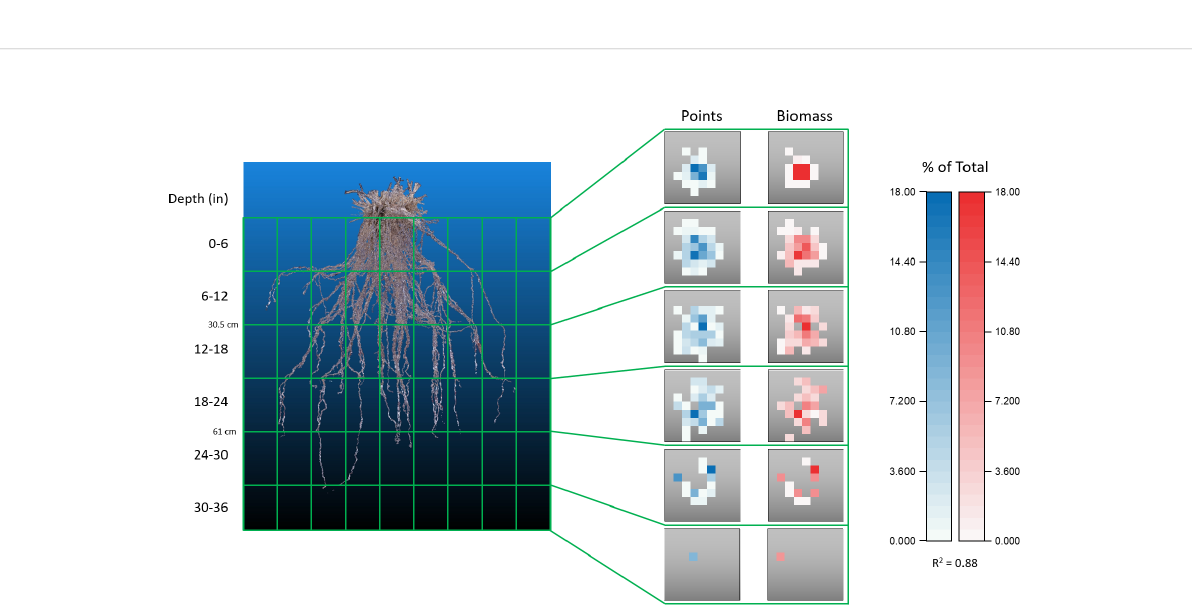
FIGURE 9 Biomass con fi rmation of point cloud accuracy. Comparison of data obtained from a switchgrass root system that had been physically and digitally dissected into the 180 independent sections outlined by the internal PVC and fi shing line scaffold. Each gray square is a top-down view of a z-layer consisting of 9 x 9 cuboids. Data within each square represents the number of points, or the fraction of biomass, found in a cuboid as a percentage of the entire root system. Physical segmented biomass values correlate well with values of point number located in the same cuboid coordinate position when assessed on a relative scale, R 2 = 0.88.